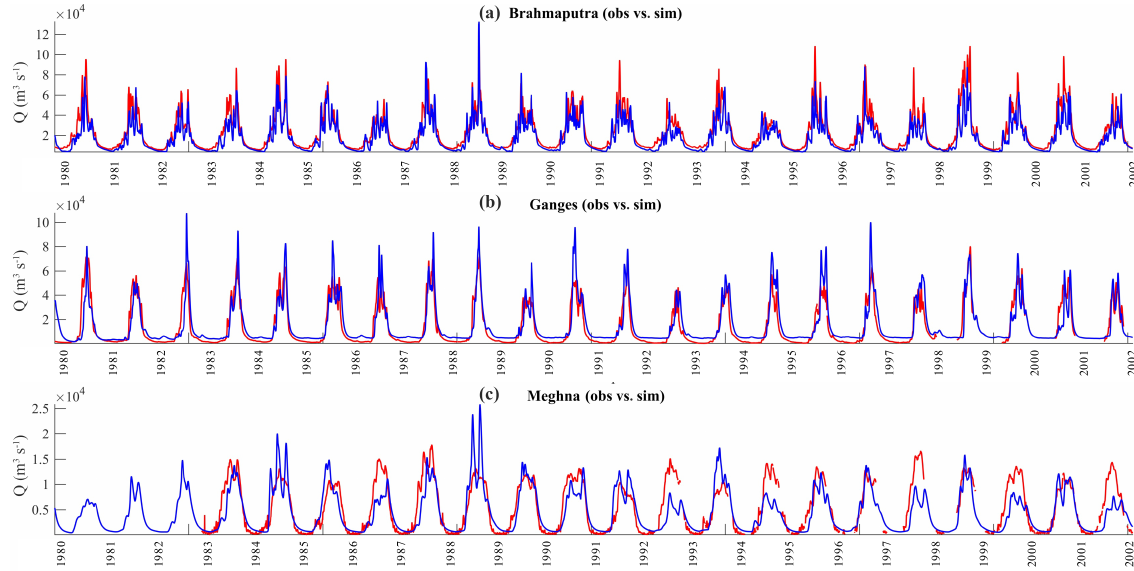
Figure 7. Comparisons of the observed (red) and BTOPMC simulated (blue) discharges at (a) the Bahadurabad, the Brahmaputra, (b) Hardinge Bridge, the Ganges, and (c) Bhairab Bazar, the Meghna. The calibration period is 1980–1990. Precipitation data used are WATCH Forcing Data (WFD). See Table 1 for the Nash–Sutcliffe efficiency.